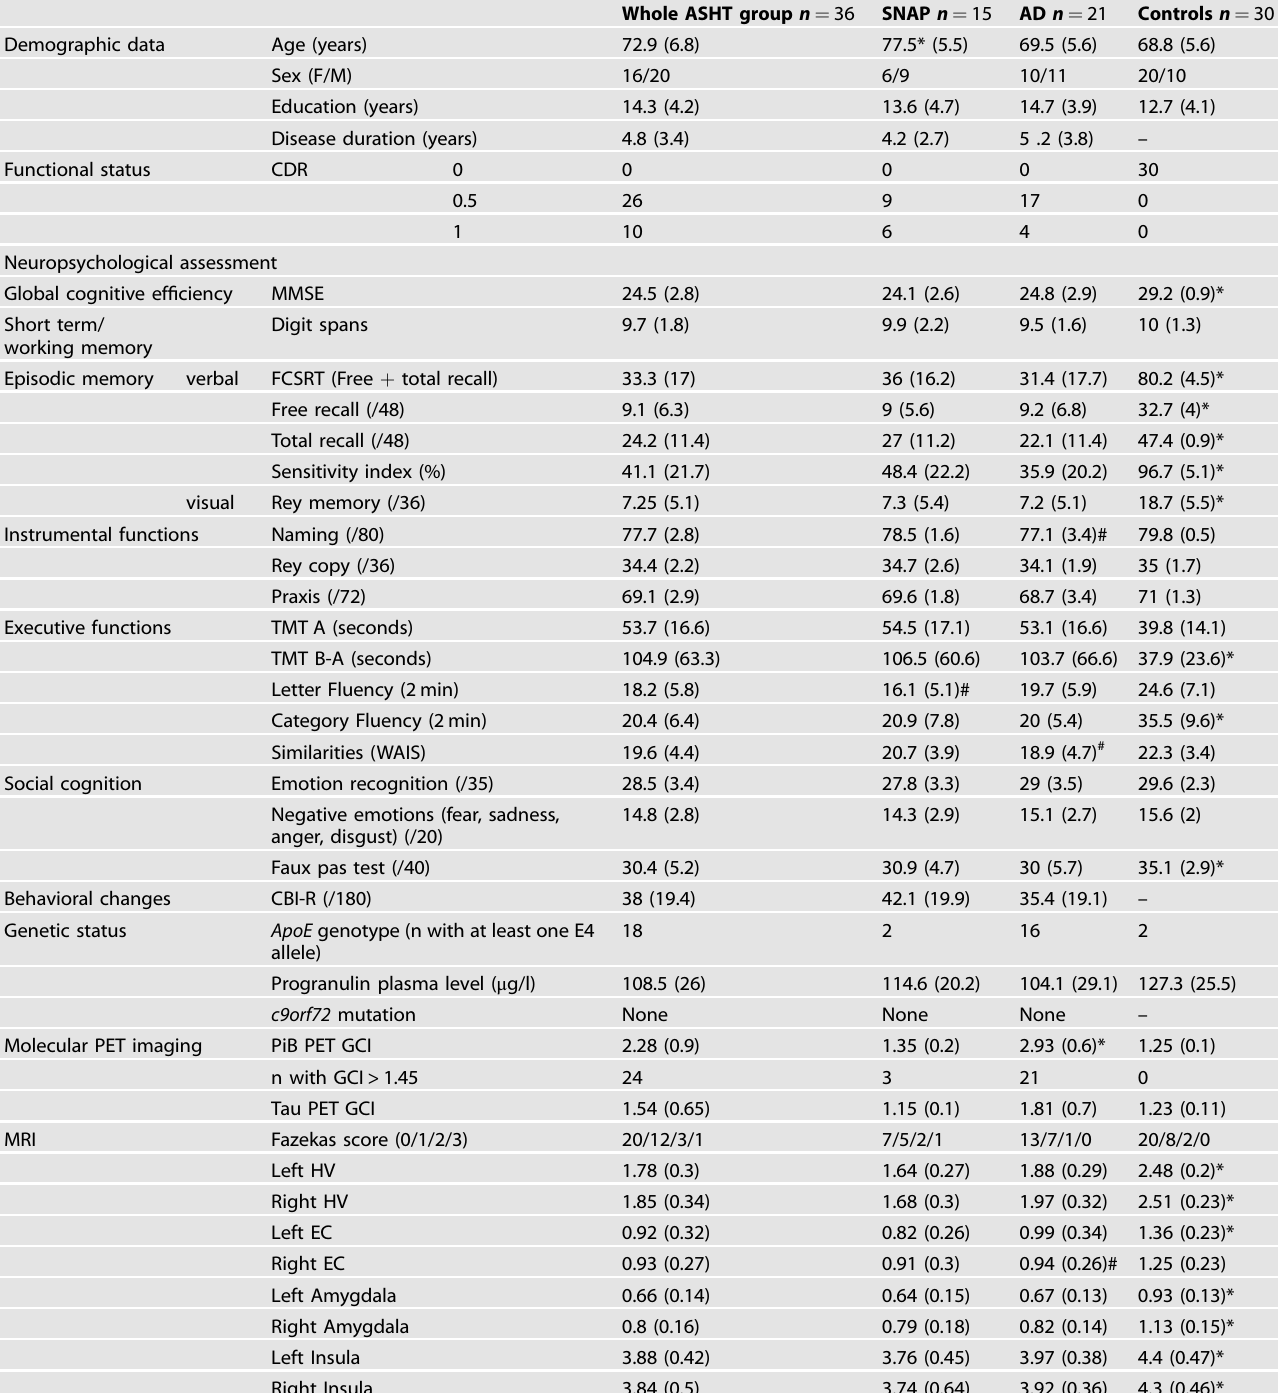
Table 1. Main demographic, clinical, imaging, and biological data at baseline for the patient and control groups (mean